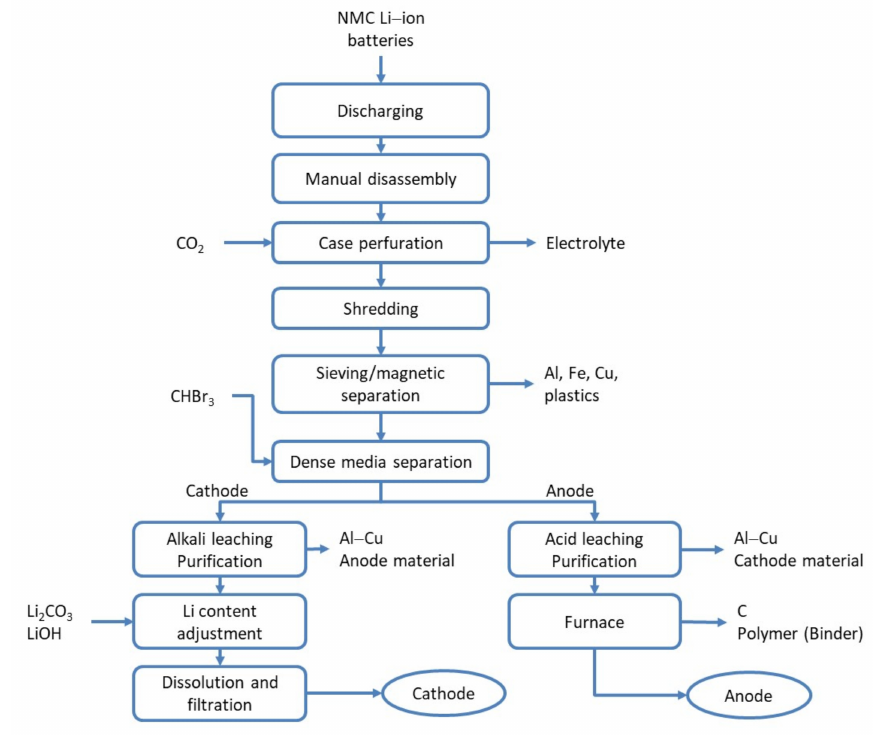
Figure 4. Recycling process of OnTo Technology using precipitation steps for synthesis of NMC type cathode from spent Li-ion batteries [15,30]. Adapted with permission form ref. [30]. 2021 Springer